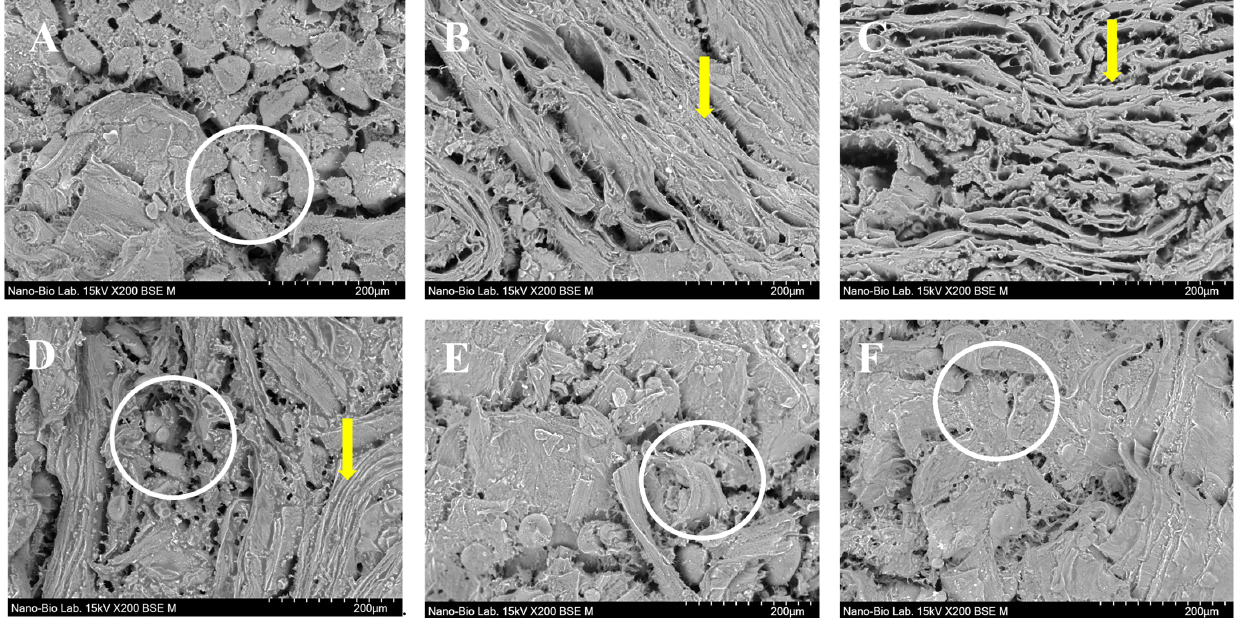
Figure 5. Scanning electron microscope images of vertically cut PBMPs with different binders (×200 magnification). ( A ): control; ( B ): G0T10, GdL:TG = 0:10; ( C ): G3T7, GdL:TG = 3:7; ( D ): G5T5, GdL:TG = 5:5; ( E ): G7T3, GdL:TG = 7:3; ( F ): G10T0, GdL:TG = 10:0.